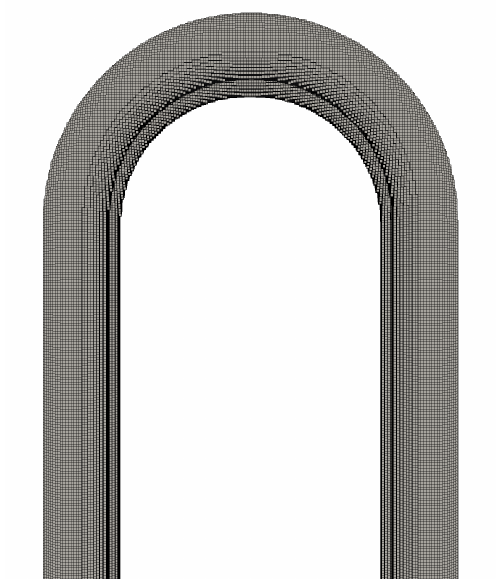
Figure 8. Voxelized measuring pipes of the LBM